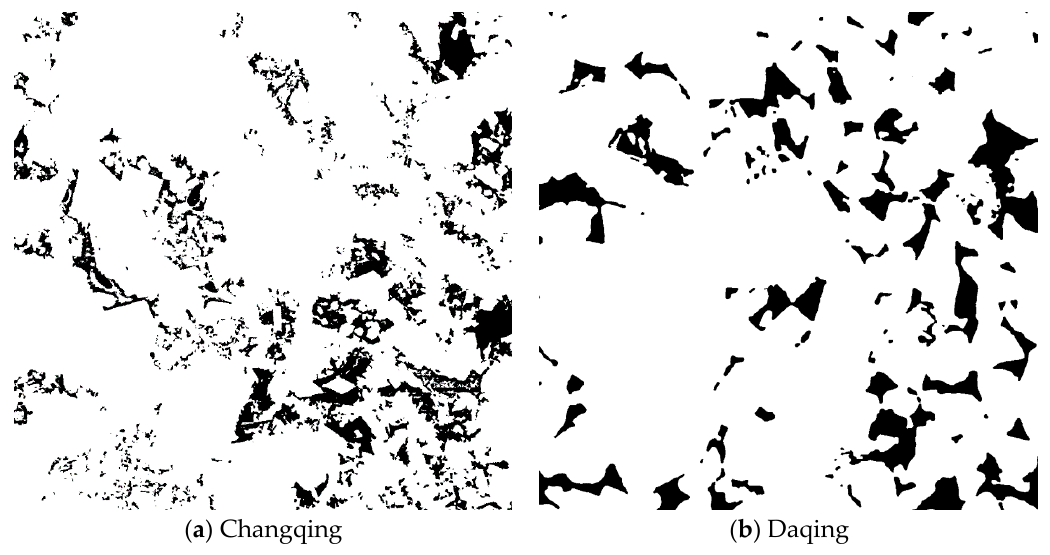
Figure 2. 2D slice of reconstructed base structure (black part are pores, same in following figures).